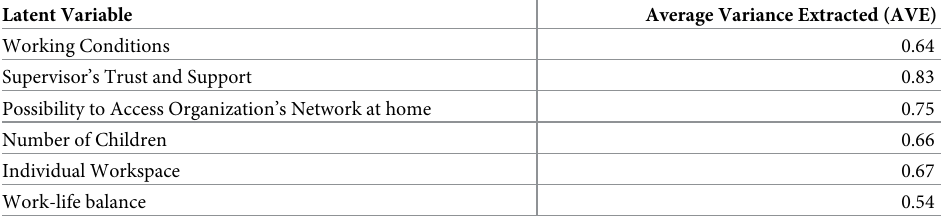
Table 3. AVE scores of latent variables.